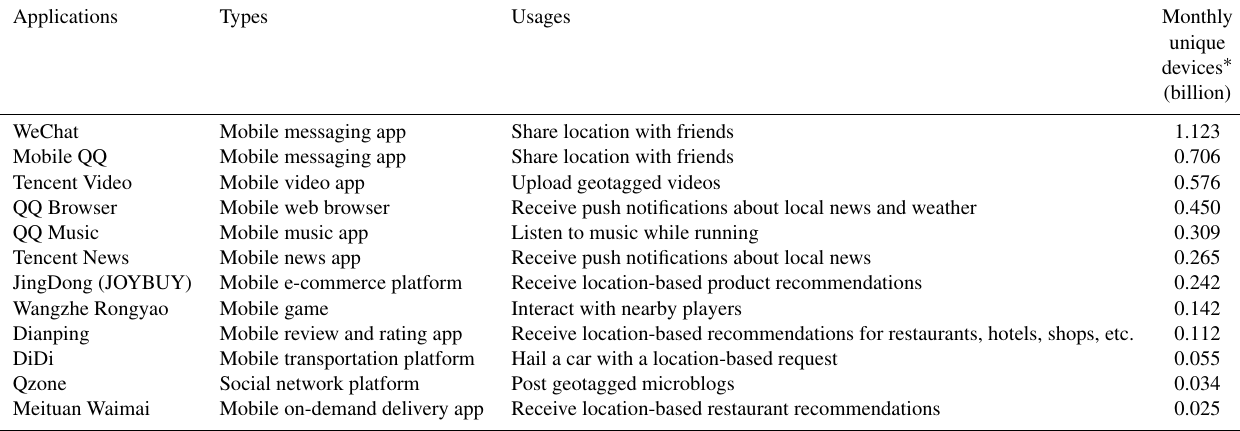
Table 2. Common smartphone applications using location-based